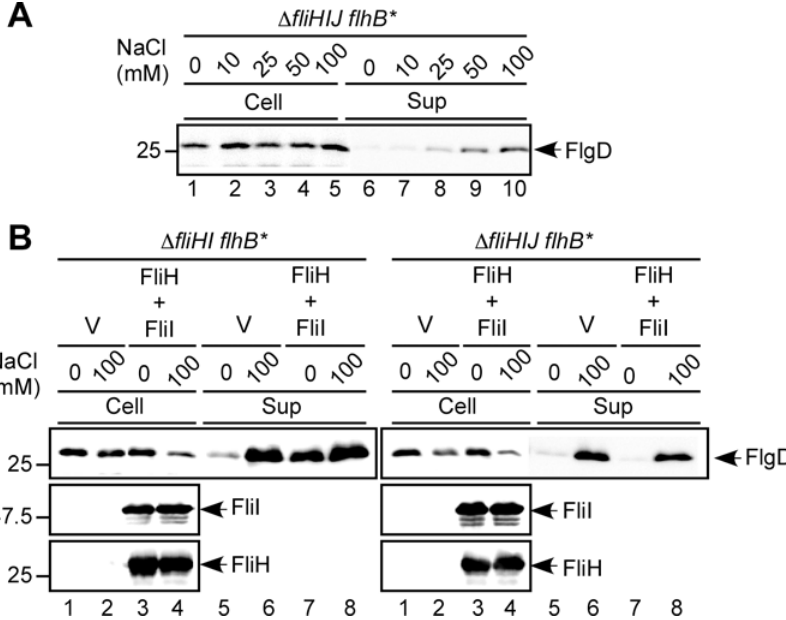
Fig 5. Effect of FliJ deletion on Na + -dependent flagellar protein export. (A) Effect of external Na + concentration on FlgD secretion by the Δ fliH-fliI-fliJ flhB(P28T) mutant cells. Immunoblotting, using polyclonal anti-FlgD antibody, of whole cell proteins (Cells) and culture supernatant fractions (Sup) prepared from MMHIJ0117 ( Δ fliHIJ flhB * ) grown at 30°C in T-broth 10 mM, 25 mM, 50 mM or 100 mM NaCl at external pH 7.5. (B) Effect of external Na + on FlgD secretion by the Δ fliH-fliI flhB(P28T) and Δ fliH-fliI-fliJ flhB(P28T) mutant strains in the presence and absence of FliH and FliI. Immunoblotting, using polyclonal anti-FlgD, anti-FliH or anti-FliI antibodies, of whole cell proteins and culture supernatant fractions prepared from MMHI0117 ( Δ fliHI flhB * ) (left panel) or MMHIJ0117 ( Δ fliHIJ flhB * ) carrying pTrc99A (V) or pMMHI001 (FliH + FliI) grown exponentially at 30°C in T-broth with or without 100 mM NaCl at external pH